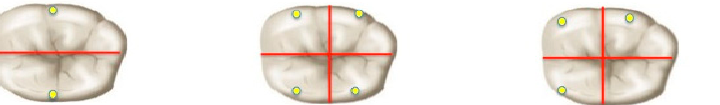
Figure 1. Teeth sections perpendicular to the occlusal surface (in red): 2, 3, or 4 enamel opacities were obtained (in yellow).